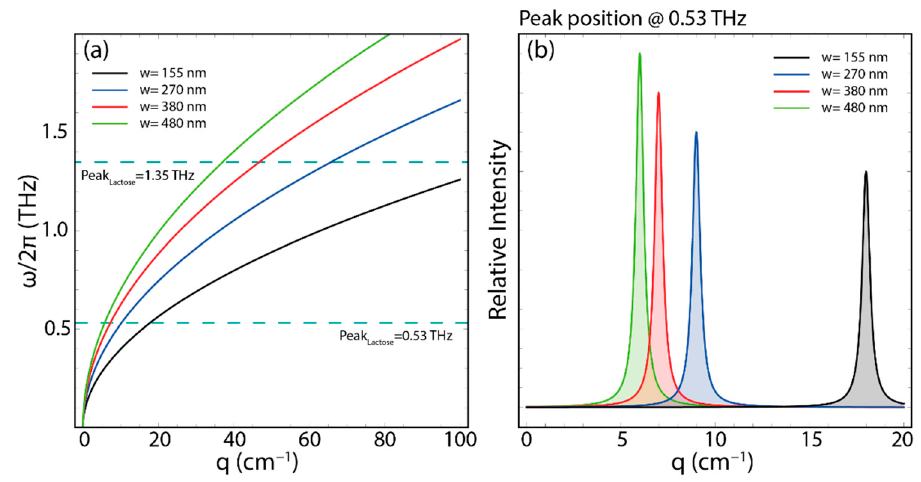
Figure 16. ( a ) Plasmon frequency dispersion ( ≤ 2 THz) ( ω /2 π ) vs. wave vector, considering different ribbons widths (155, 270, 380, and 480 nm). The parameters of Equation (4) have been fixed as: N 2 D = 1.0 × 10 12 cm − 2 , θ = 0, and ν = 0.0 s − 1 . ( b ) Plasmon excitation lifetime at 1 THz for momentum q ≤ 20 cm − 1 , considering different ribbons widths (155, 270, 380, and 480 nm). The spectra were calculated using the Lorentzian shape function to a maximum value of 1 with FWHM = 0.5 .